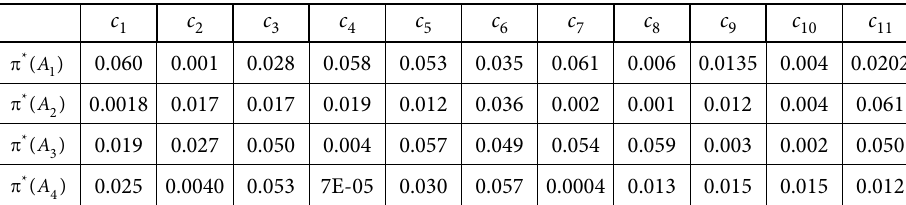
Table 5. Hesitate degree of possibility index p